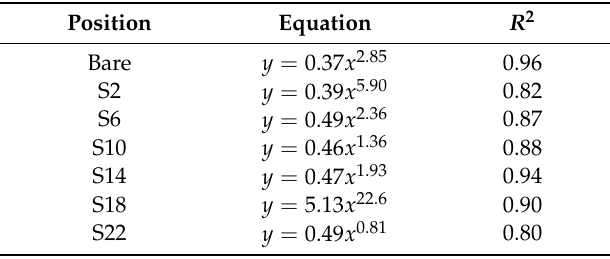
Figure 9. The vertical flow velocity distribution related to the relative water depth at different positions. Table 6. The curve fitting equations of vertical distribution profiles.